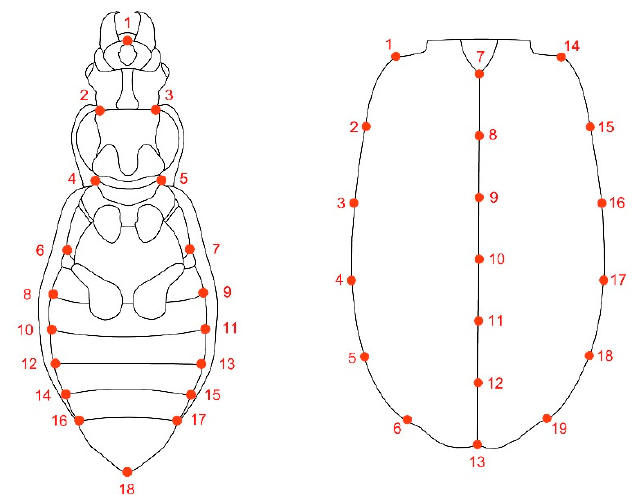
Figure 1. Graphical representation of the location of the 18 and 19 Landmarks (LMs) in ventral and elytral view for the different ground beetle species.